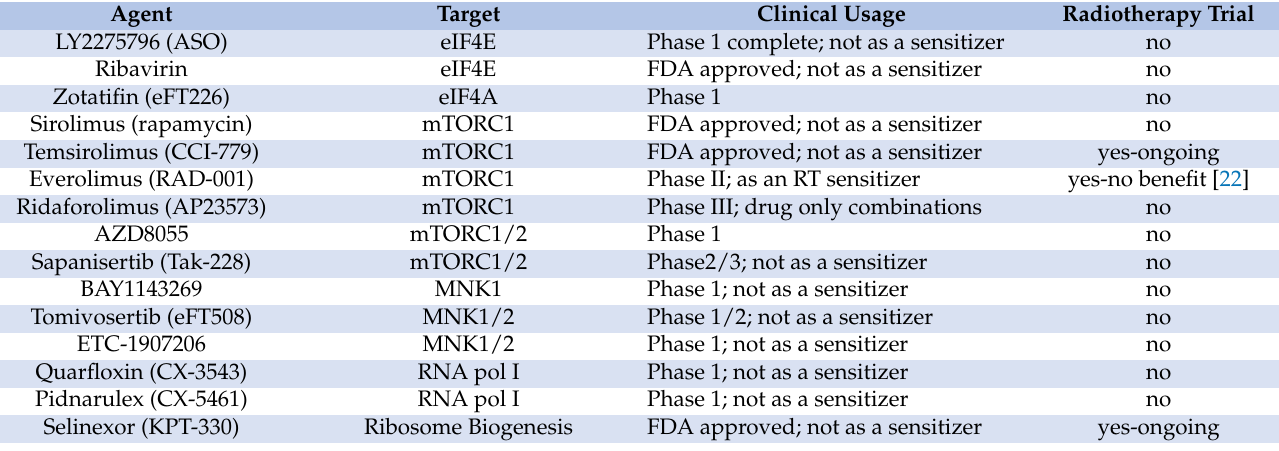
Table 1. Translation initiation inhibitors in clinical trials. Summary of the usage of inhibitors discussed this article that are in clinical trials or have FDA